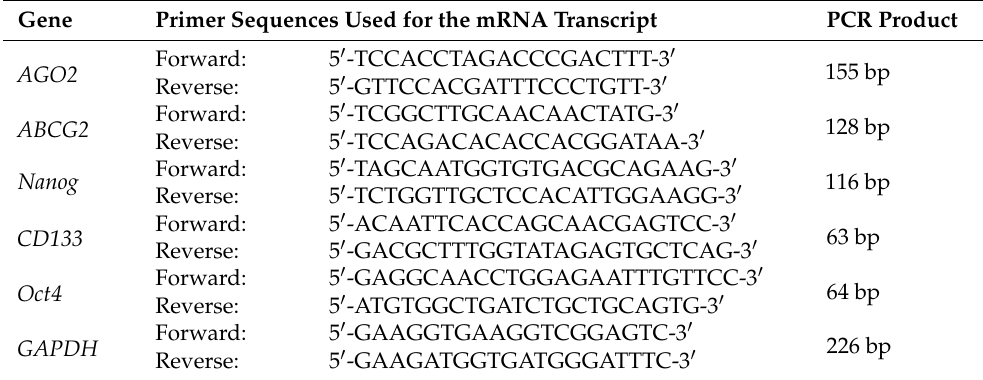
Table 1. Primer sets used for qRT-PCR